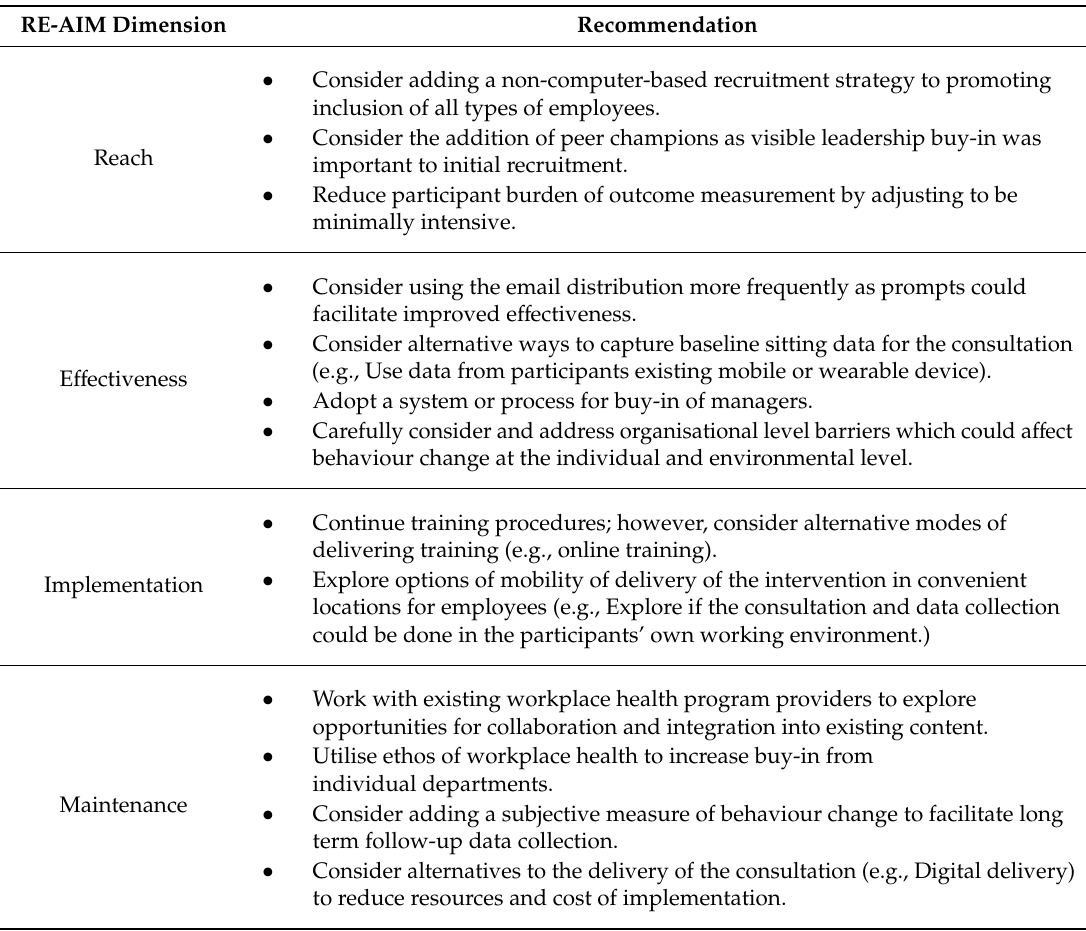
Table 4. Recommendations for scaling up the sedentary behaviour